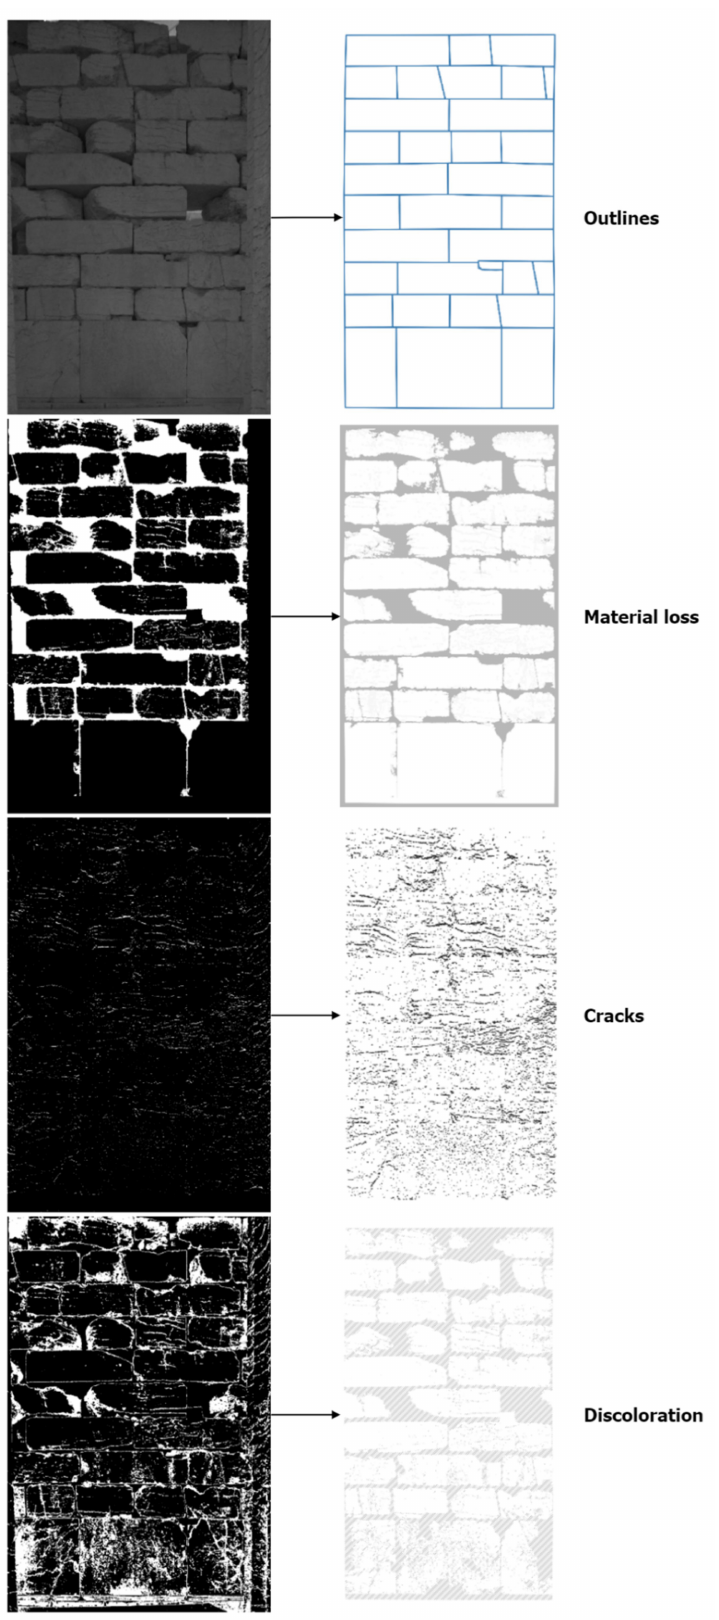
Figure 5. Generation of thematic map layers ( right ) in QGIS using features extracted from rectified near-infrared reflectance images ( left ) for the Temple of Apollo